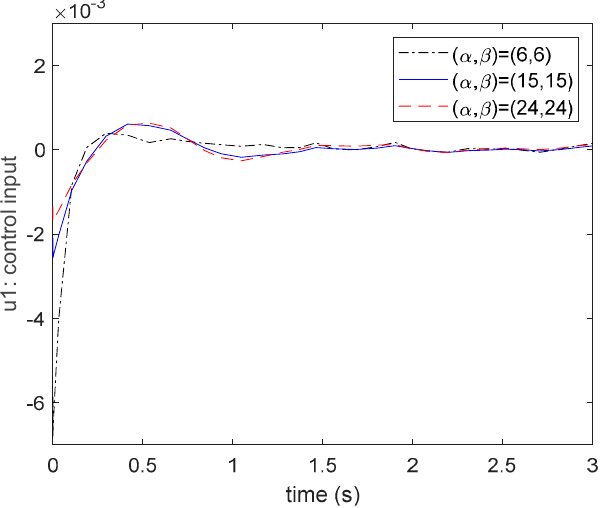
Figure 11. The comparisons of state x ( t ) responses for different circle regions.